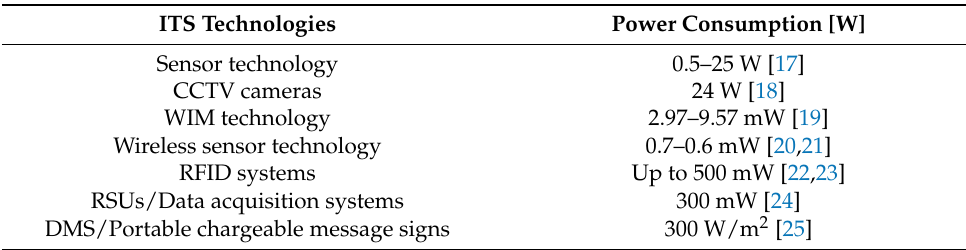
Table 1. Energy consumption of the ITS technologies.